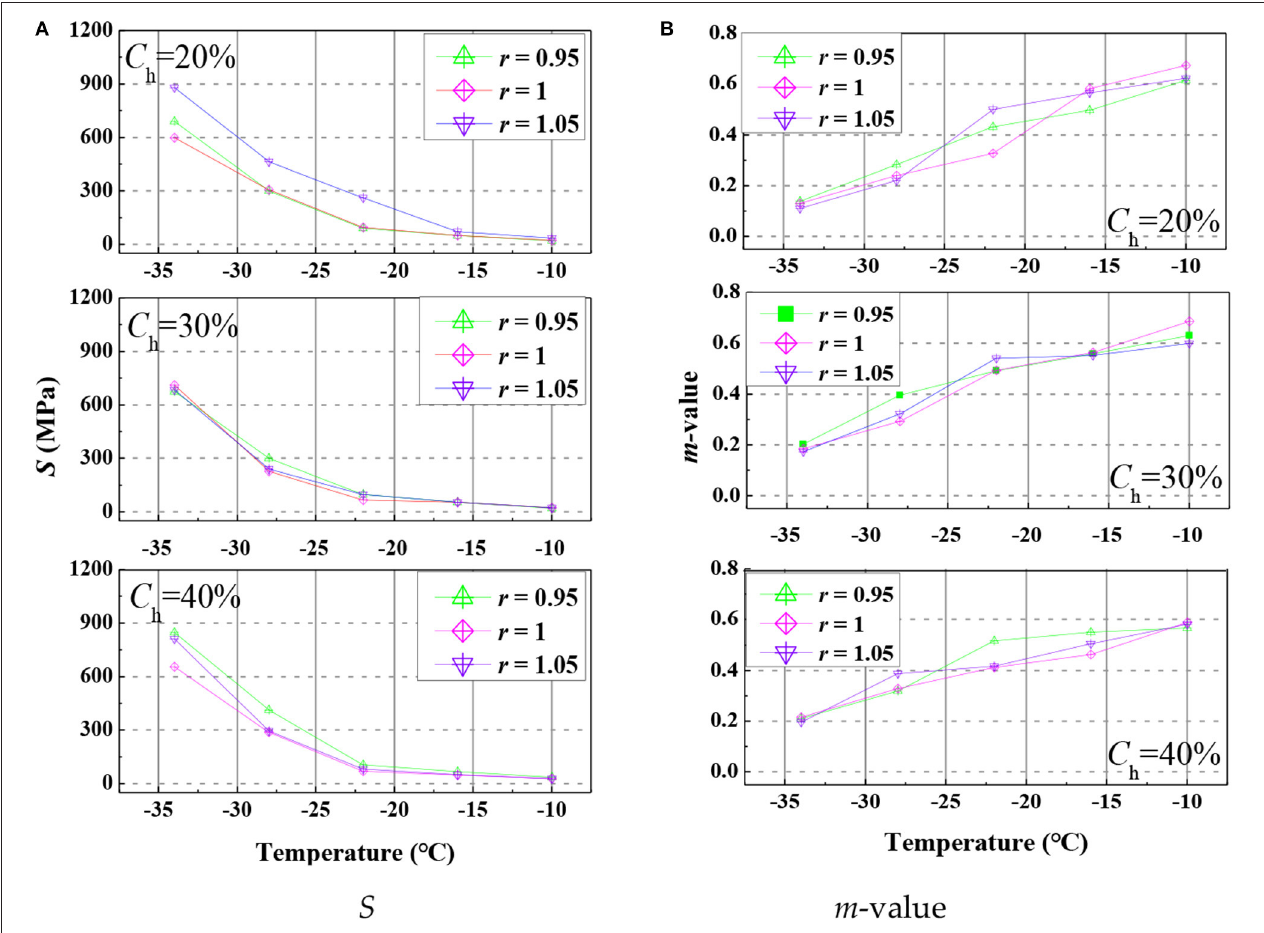
FIGURE 30 | BBR test results of polyether-based TPU-modified asphalt. (A) S. (B) m -value.